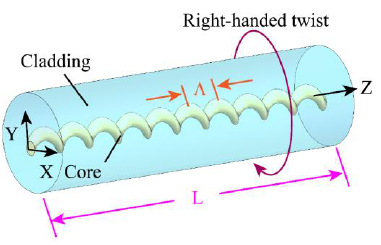
Figure 1. The corresponding configuration of the SMF-HLPG. The dual resonance characteristics of the SMF-HLPG near the DTP were simulated. eters were 9 and 125 µm, respectively. This fiber had a core refractive index of 1.461 and a